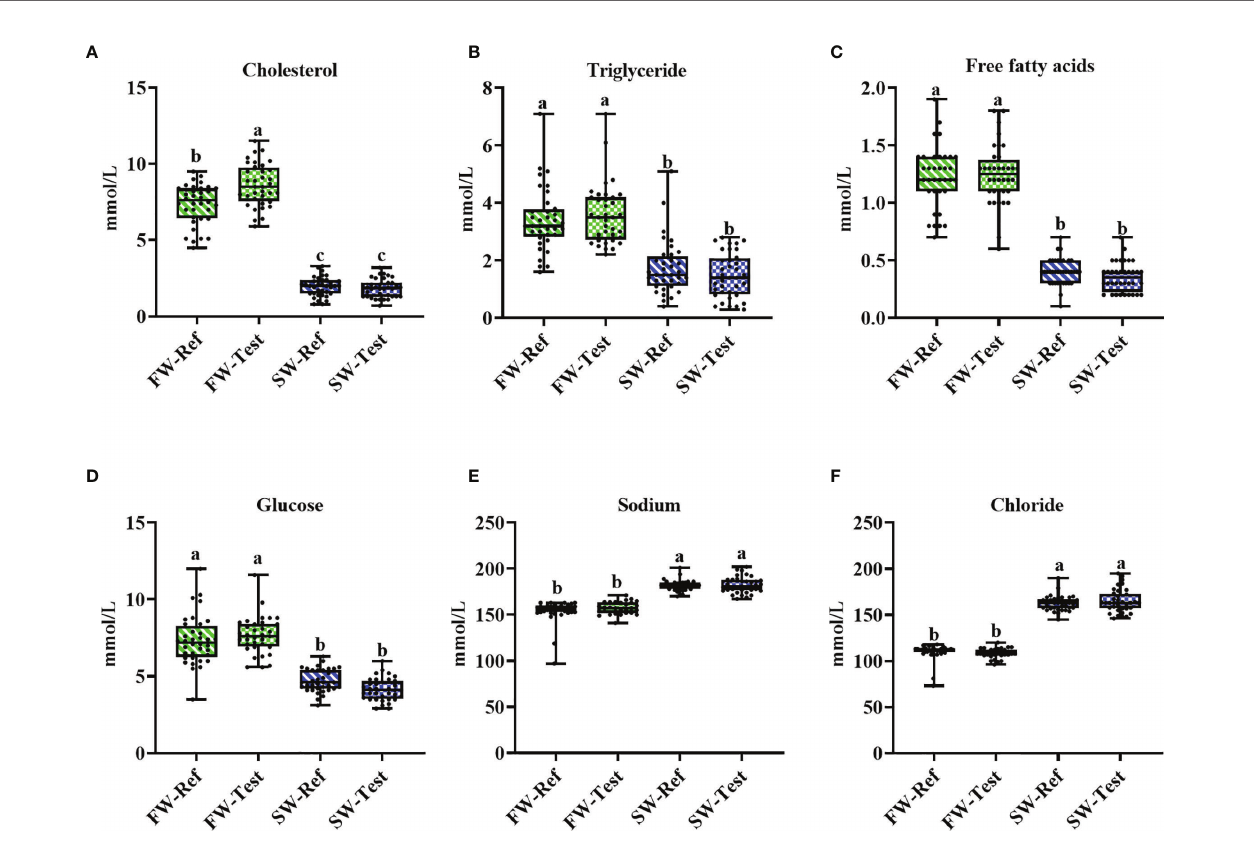
FIGURE 2 | Changes in the measured plasma metabolites in Atlantic salmon fed different diets before and after the seawater transfer. (A-D) plasma nutrients; (E, F) plasma ions. Data are presented from min to max with all points. Different letters among values denote signi fi cant differences ( p < .05, n = 36) and values sharing the same letters are not signi fi cantly